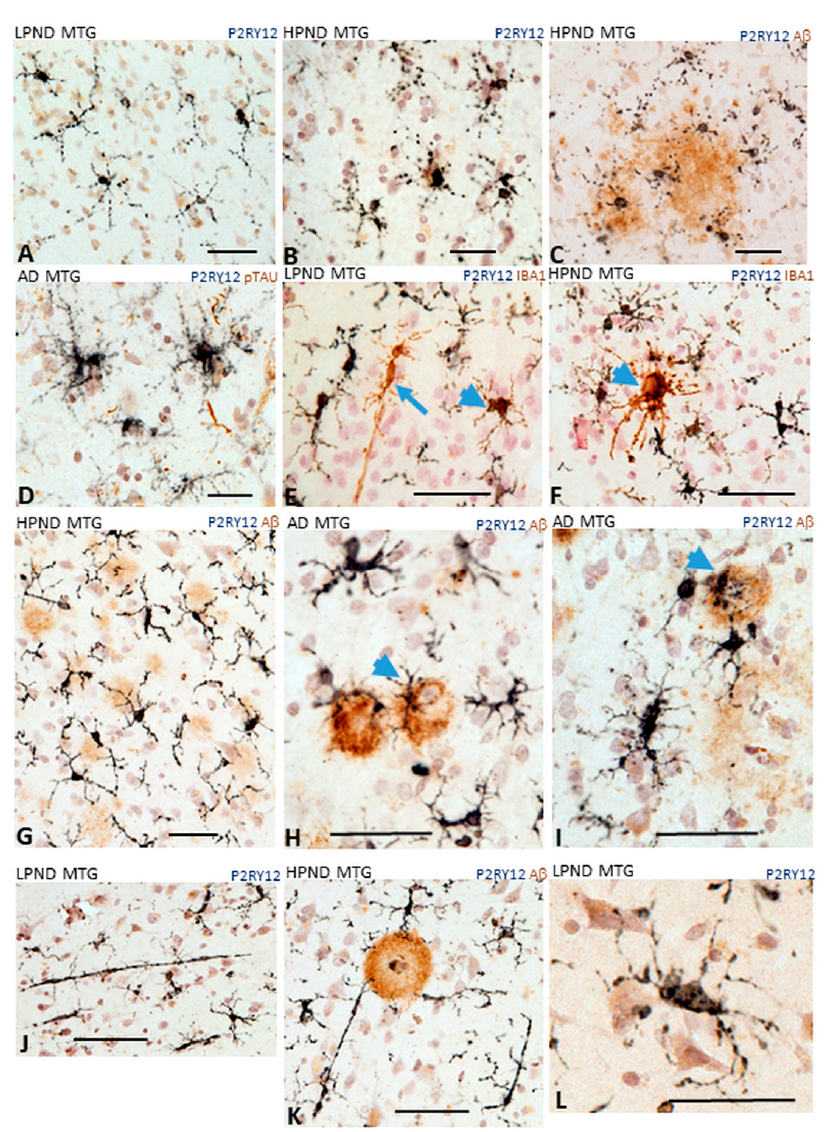
Figure 5. Di ff erent microglial morphologies associated with P2RY12 expression. Representative immunohistochemistry results of tissue sections stained to identify P2RY12 (purple) alone and A β (brown), IBA-1 or phosphorylated tau. ( A ). Ramified microglia in LPND case. ( B , C ). Microglia with fragmented morphology in HPND cases. ( C ). Fragmented microglia associated with di ff use A β plaques. ( D ). P2RY12 microglia with tufted morphology in AD case. ( E , F ). Colocalization of P2RY12 and